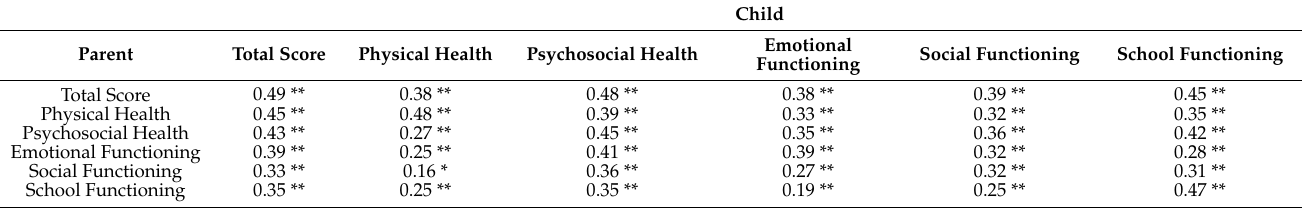
Table 4. Spearman correlations between the child’s (8–13 years) (n = 219) and the parent proxy-report of HRQoL.